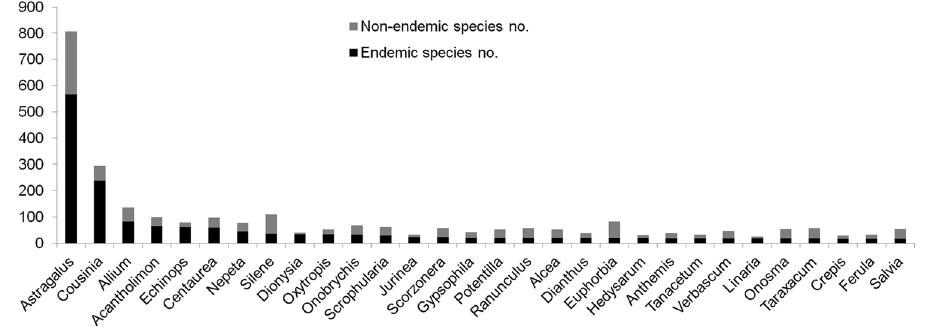
Figure 3. Number of endemic and non-endemic species of the 30 most endemic-rich genera of the Iranian vascular flora (sorted by number of endemic species).